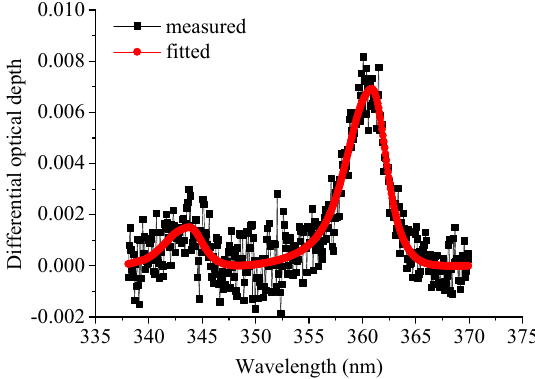
Figure 2. Example of spectral fitting for O 4 corresponding to the elevation angle of 10° at 11:56 LT (local time, UTC + 8 h) on 13 June 2014. The black and red symbol-lines indicate the derived absorption structures from the measured spectra and the fitted absorption cross section, respectively. The fitted O 4 differential slant column density (dSCD) is 1.65 × 10 43 molec 2 ·cm − 5 , and the root mean square (RMS) of fitting residual between measured and fitted spectrum is 7.63 × 10 − 4 .